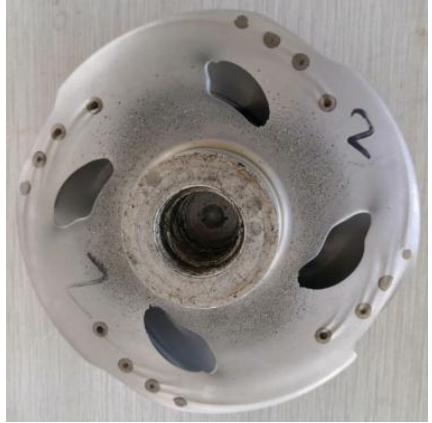
Figure 23. Photograph of the second-stage impeller wear.